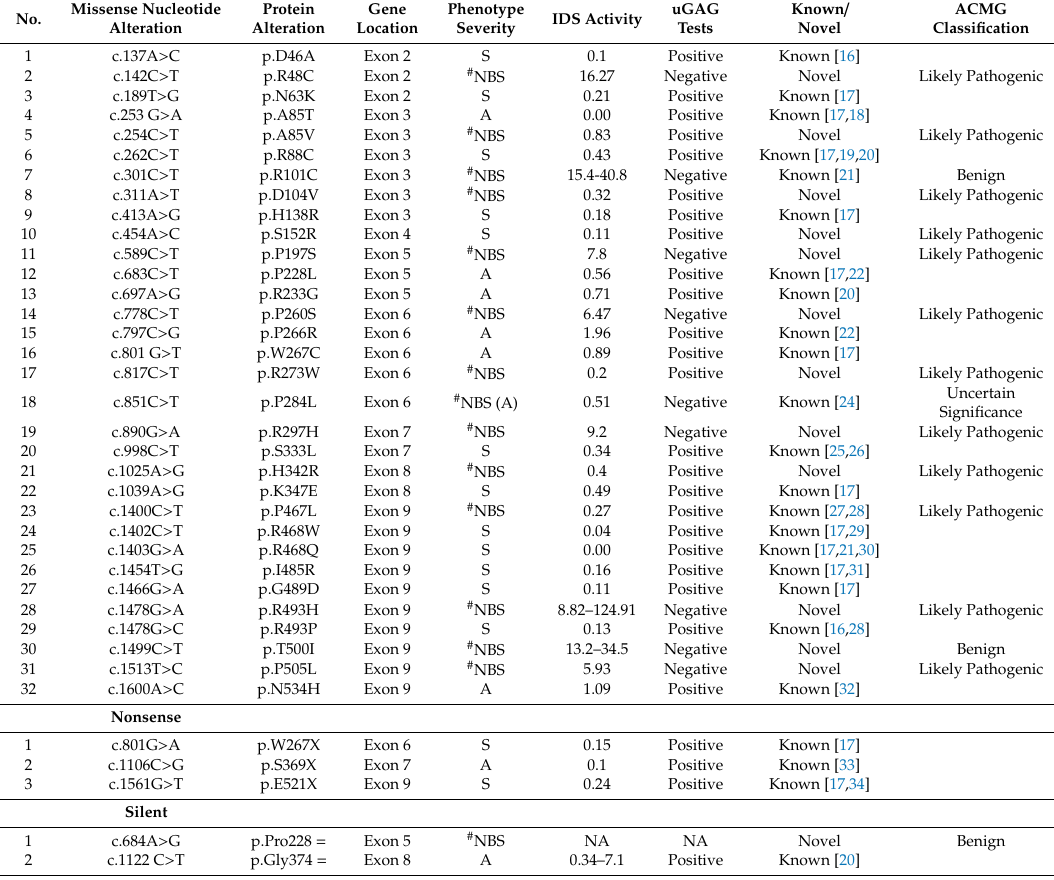
Table 1. Mutations of the iduronate-2-sulfatase ( IDS ) gene underlying Taiwanese Hunter syndrome by sequencing